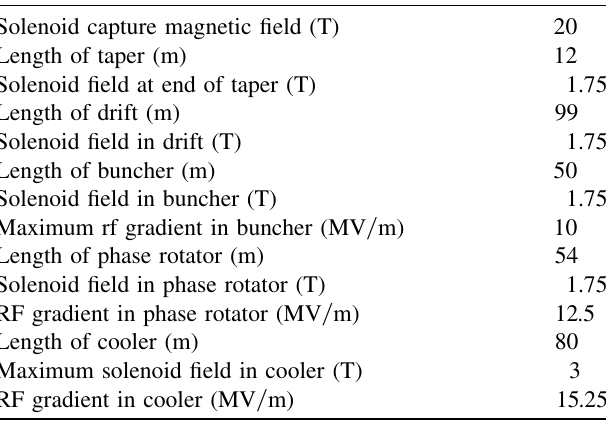
TABLE II. Summary of the front-end